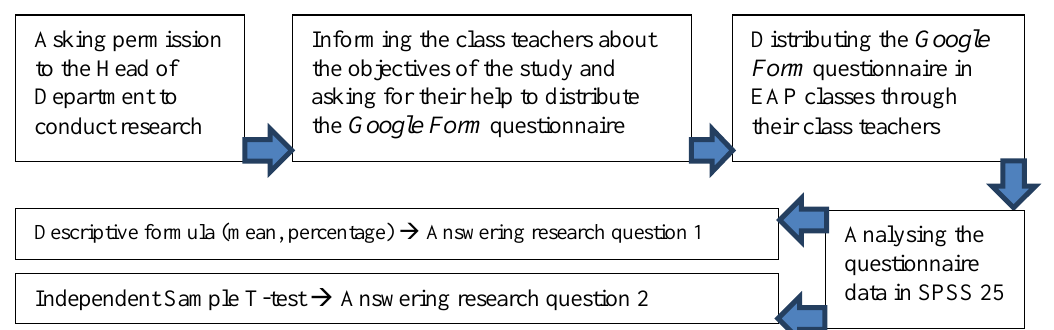
FIGURE 1 | The sequence of data collection and